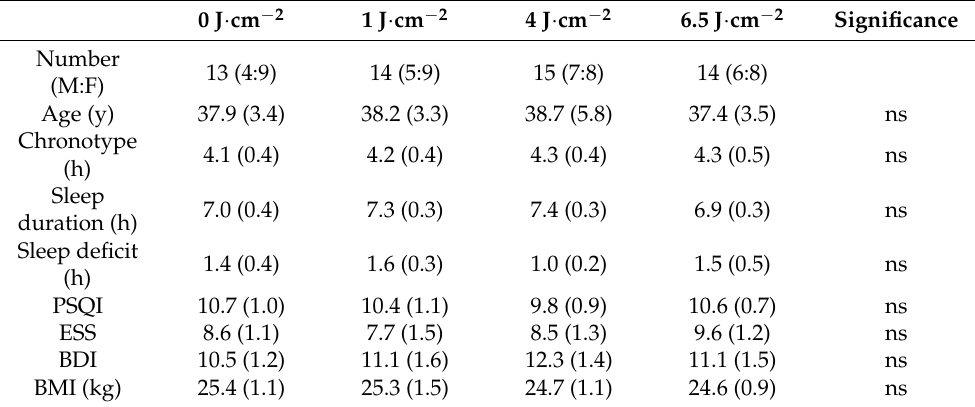
Table 2. Demographics of the individuals in the different groups for summer and winter together. Except for the number of male and female participants, all values are shown as average (standard error of the mean, SEM is noted between brackets). Abbreviations used: PSQI = Pittsburgh Sleep Quality Index, ESS = Epworth Sleepiness Scale, BDI = Beck’s Depression Inventory, BMI = Body mass index, M= Male, F =